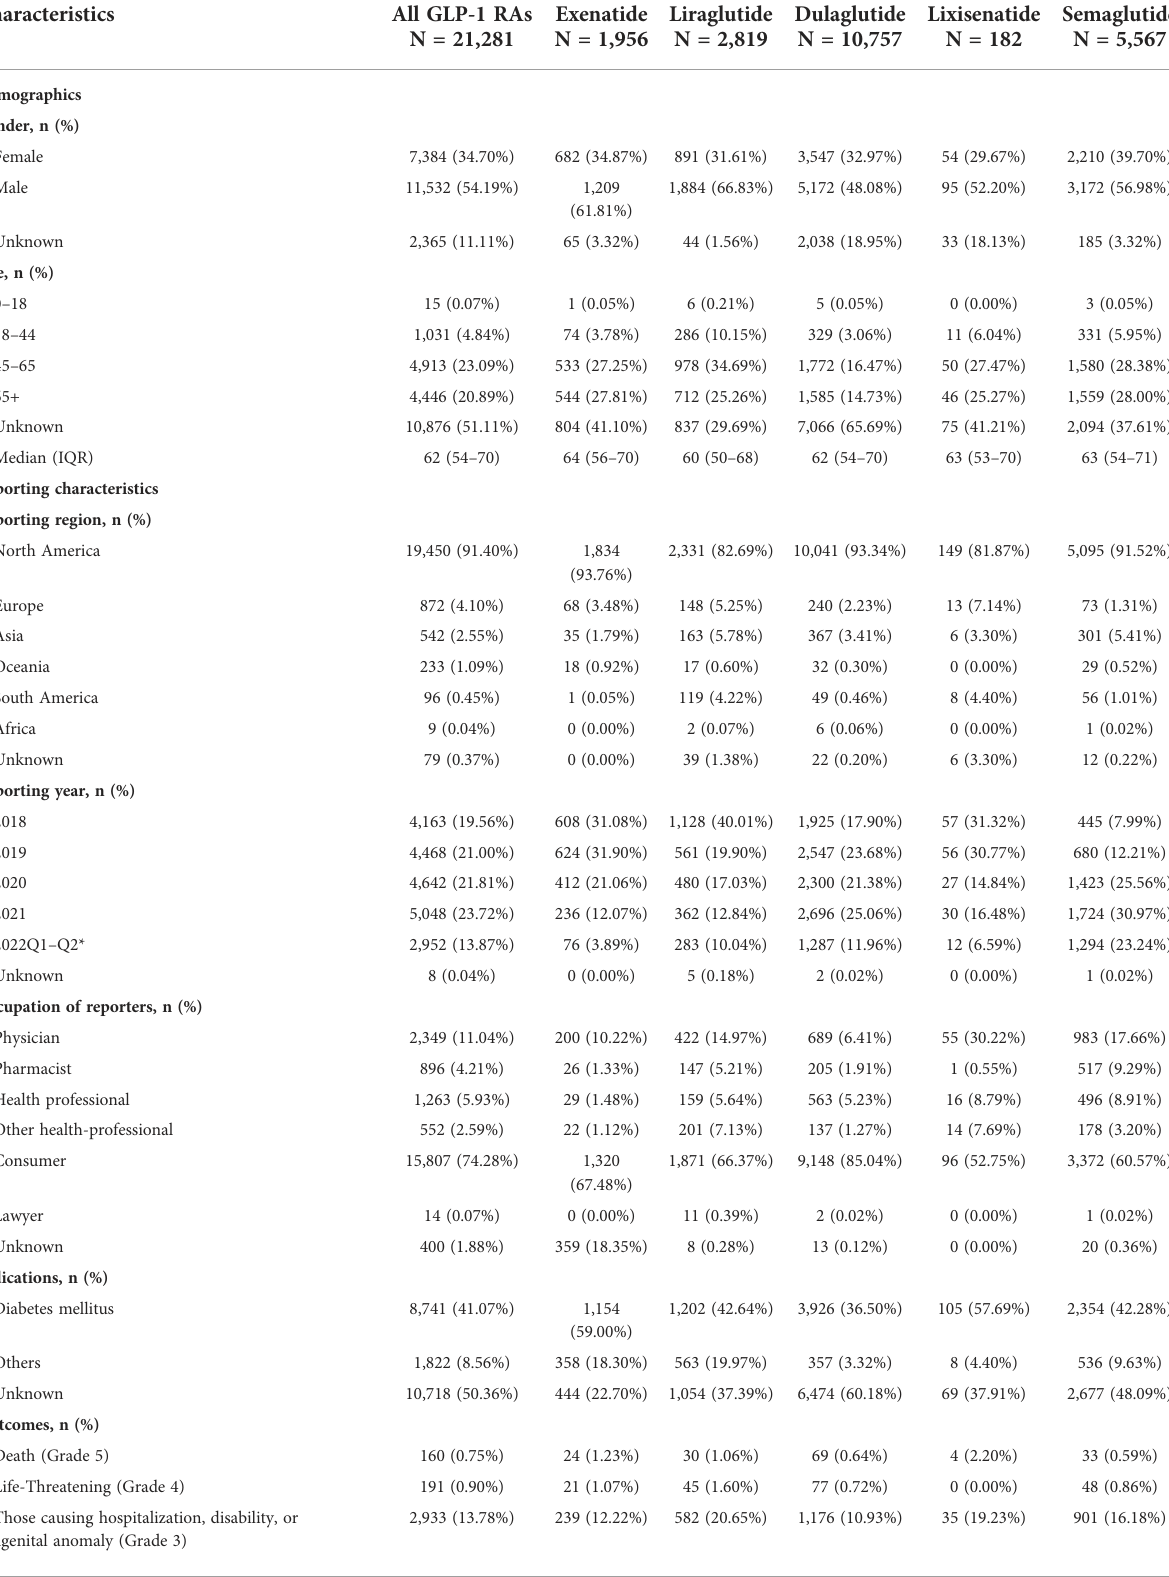
TABLE 1 The characteristics of GLP-1 RAs-associated gastrointestinal reports.